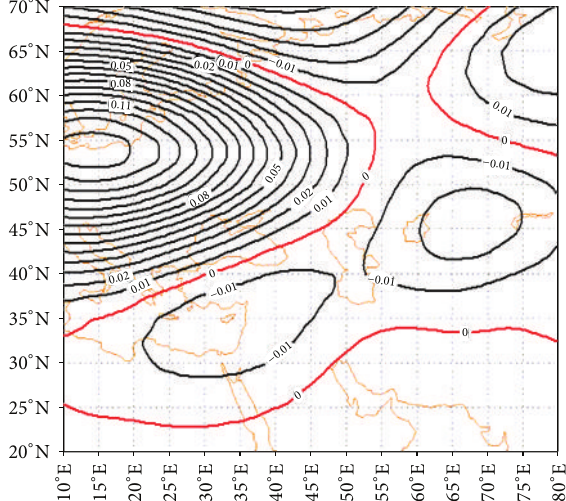
Figure22:Thefifthcomponentof500 HPageopotentialheightlevel